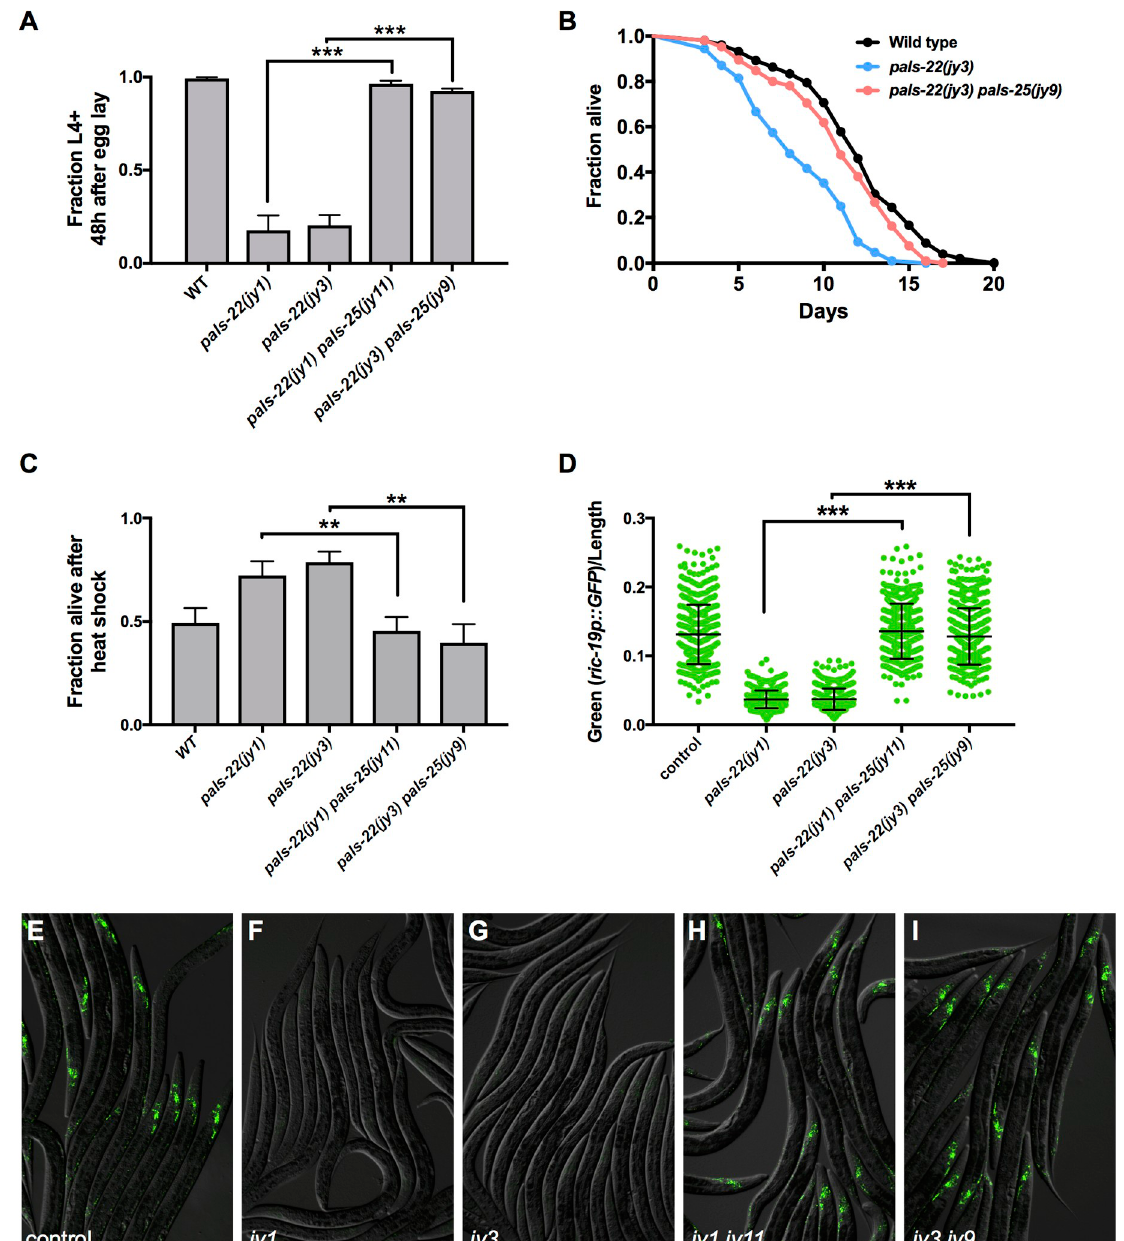
Fig 3. pals-25 mutations suppress diverse phenotypes of pals-22 mutants. (A) pals-25 mutation suppresses the developmental delay of pals-22 mutants. Fraction of animals reaching the L4 larval stage 48 hours after eggs were laid is indicated. Results shown are the average of three independent biological replicates, with 100 animals assayed in each replicate. Error bars are SD. ��� p < 0.001 with Student’s t-test. (B) Lifespan of wild type, pals-22(jy3) , and pals-22(jy3) pals-25(jy9) animals. Assays were performed with 40 animals per plate, and three plates per strain per experiment. This experiment was repeated three independent times with similar results, with data from a representative experiment shown. See S2A and S2B Fig for other replicates. p-value for pals-22(jy3) compared to pals-22(jy3) pals-25(jy9) is < 0.0001 using the Log-rank test. (C) The increased survival of pals-22 mutants after heat shock is suppressed by loss of function mutations in pals-25 . Animals were incubated for 2 hours at 37˚C followed by 24 hours at 20˚C, and then assessed for survival. Strains were tested in triplicate, with at least 30 animals per plate. Mean fraction alive indicates the average survival among the triplicates, errors bars are SD. �� p < 0.01. Assay was repeated three independent times with similar results, and data from a representative experiment are shown. See S2C and S2D Fig for other replicates. (D-I) pals-25 mutation suppresses transgene silencing in pals-22 mutants. (D) ric-19p :: GFP expression quantified in pals-22 and pals-22 pals-25 mutants using a COPAS Biosort machine to measure the mean GFP signal and length of individual animals, indicated by green dots. Mean signal of the population is indicated by black bars with error bars as SD. Graph is a